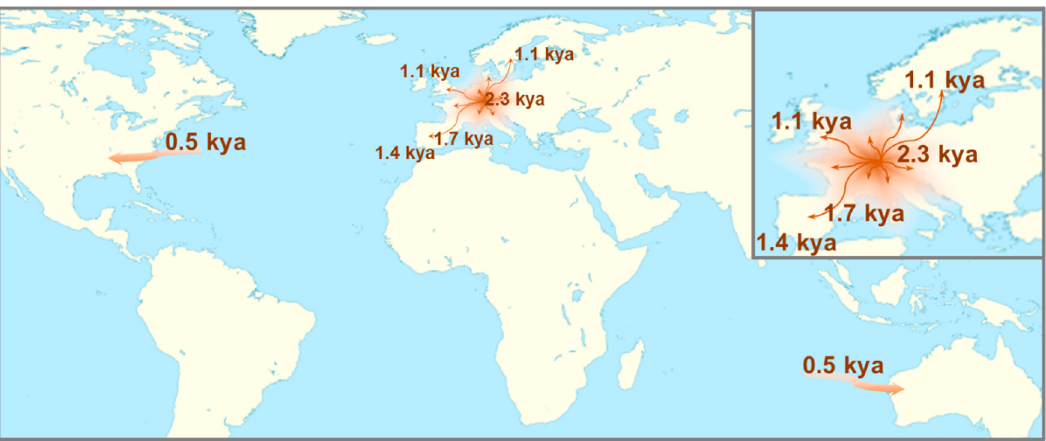
Figure 3. Possible geographic dispersal scenario inferred from present data of the populations carrying CHEK2 variant c.349A > G, with the average age estimates obtained by DMLE + 2.3, using the two population growth rates. Background map adapted from the map outline published under the terms of the GNU Free Documentation License, Version 1.2 [28].